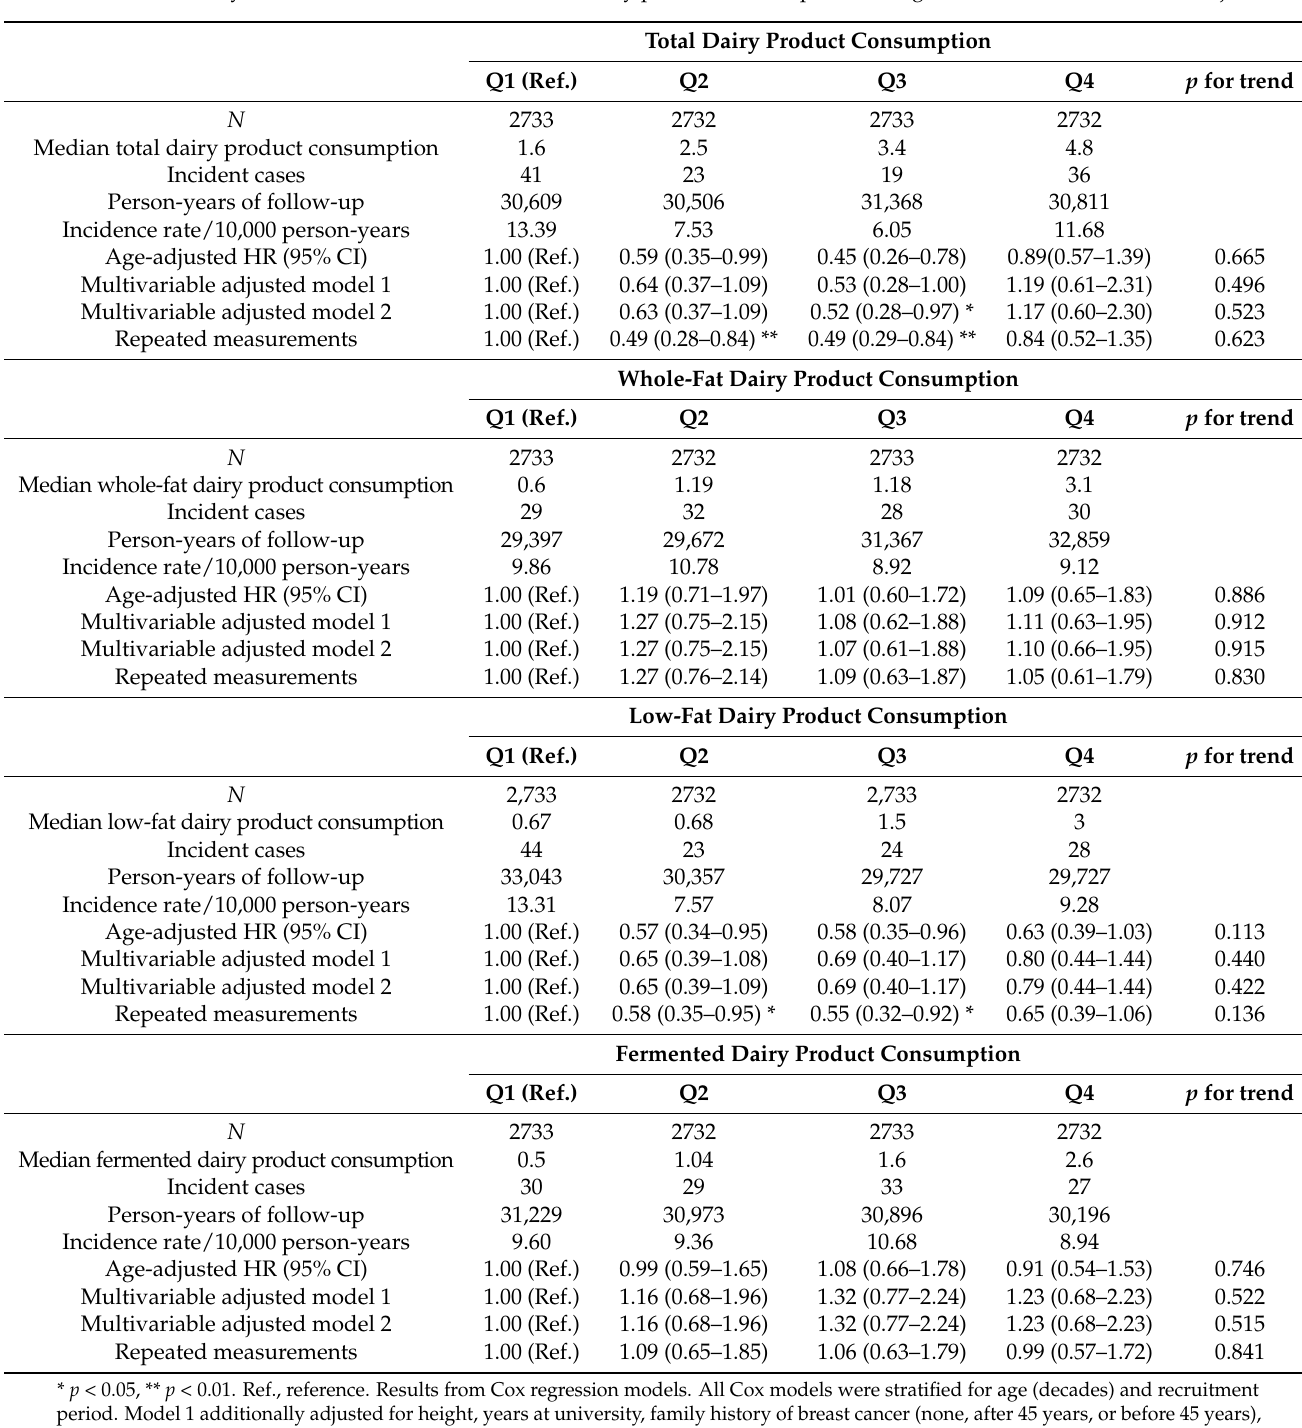
Table 2. Hazard ratio (HR) and 95% confidence intervals (CI) of confirmed breast cancer cases according to the categories of baseline total dairy, whole-fat, low-fat, and fermented dairy product consumption among 10,930 women of the SUN